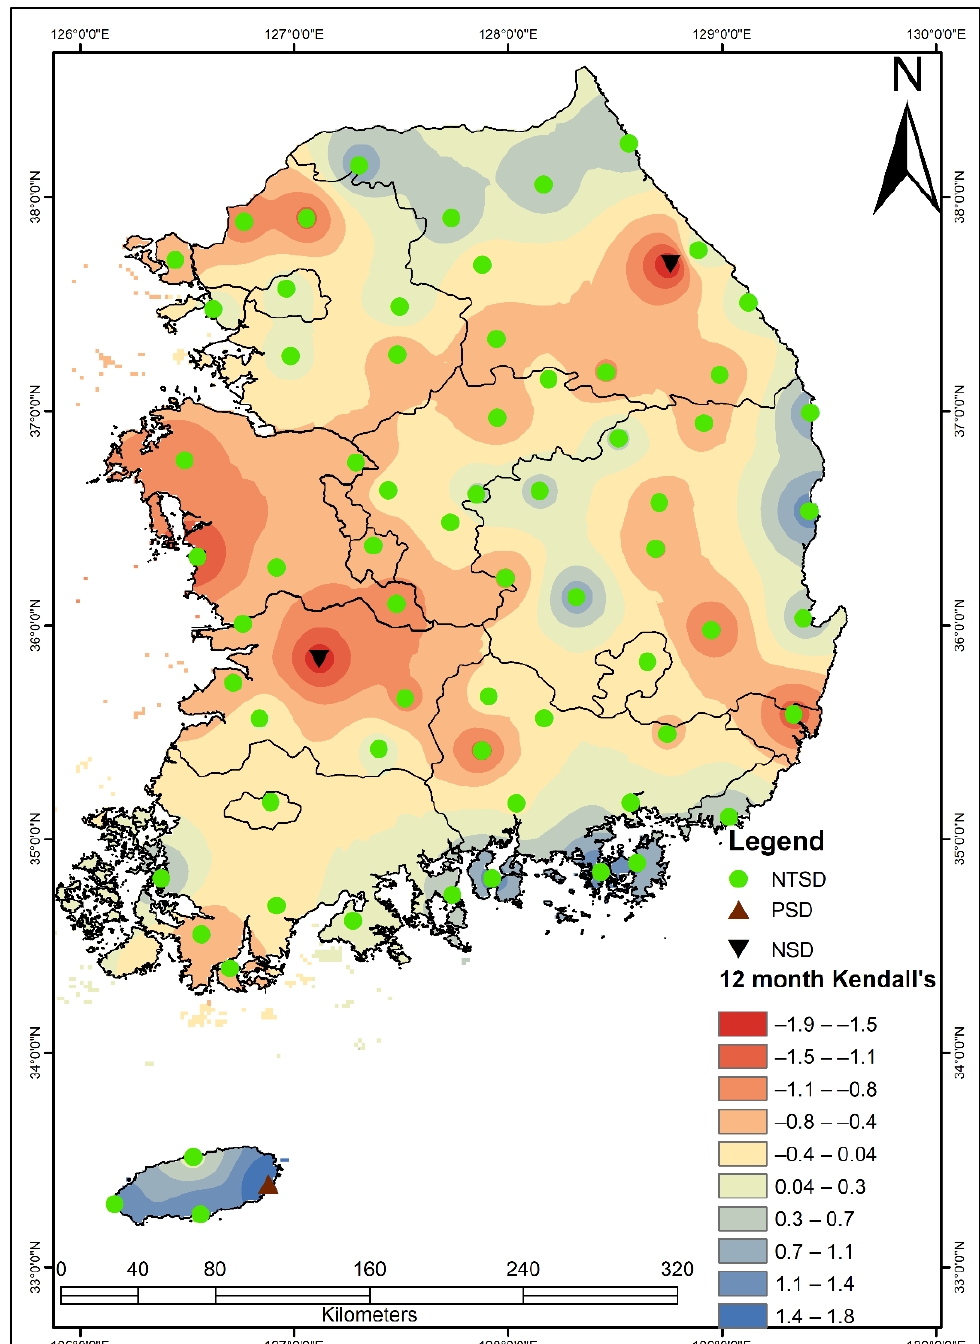
Figure 8. Spatial distribution of Kendall’s tau for 12-month SPEI series with 95% significance. Not significantly different (NTSD), positive significant difference (PSD), and negative significant difference (NSD) .